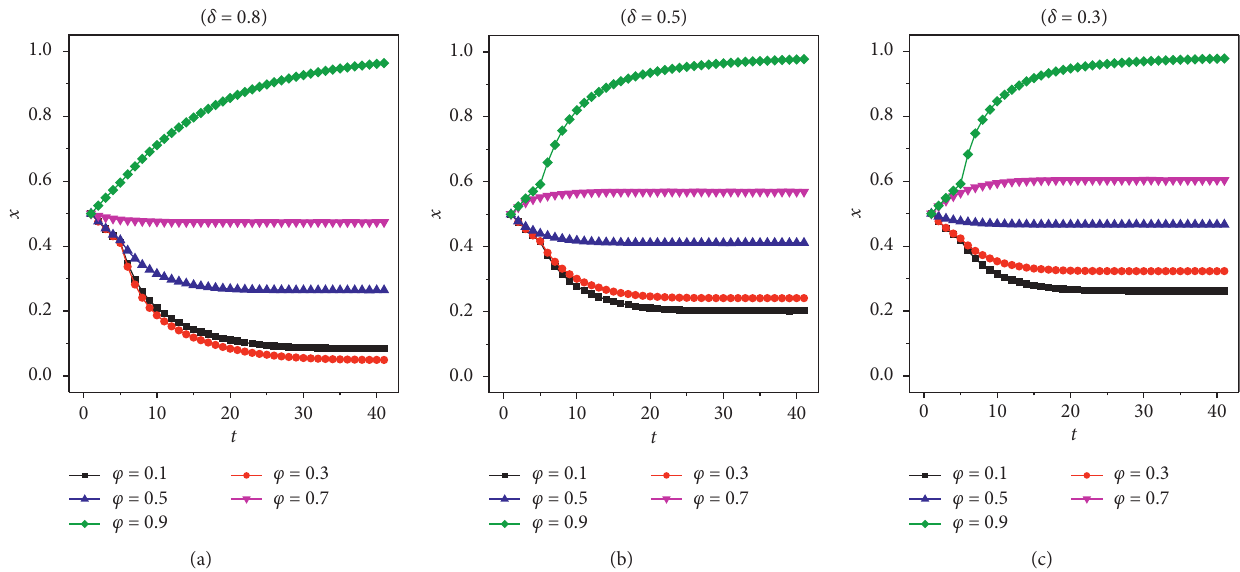
Figure 9: The proportion of innovation-leading firms in the group for different consumers’ price preference φ on three levels of the innovation risk δ based on the improved game model.